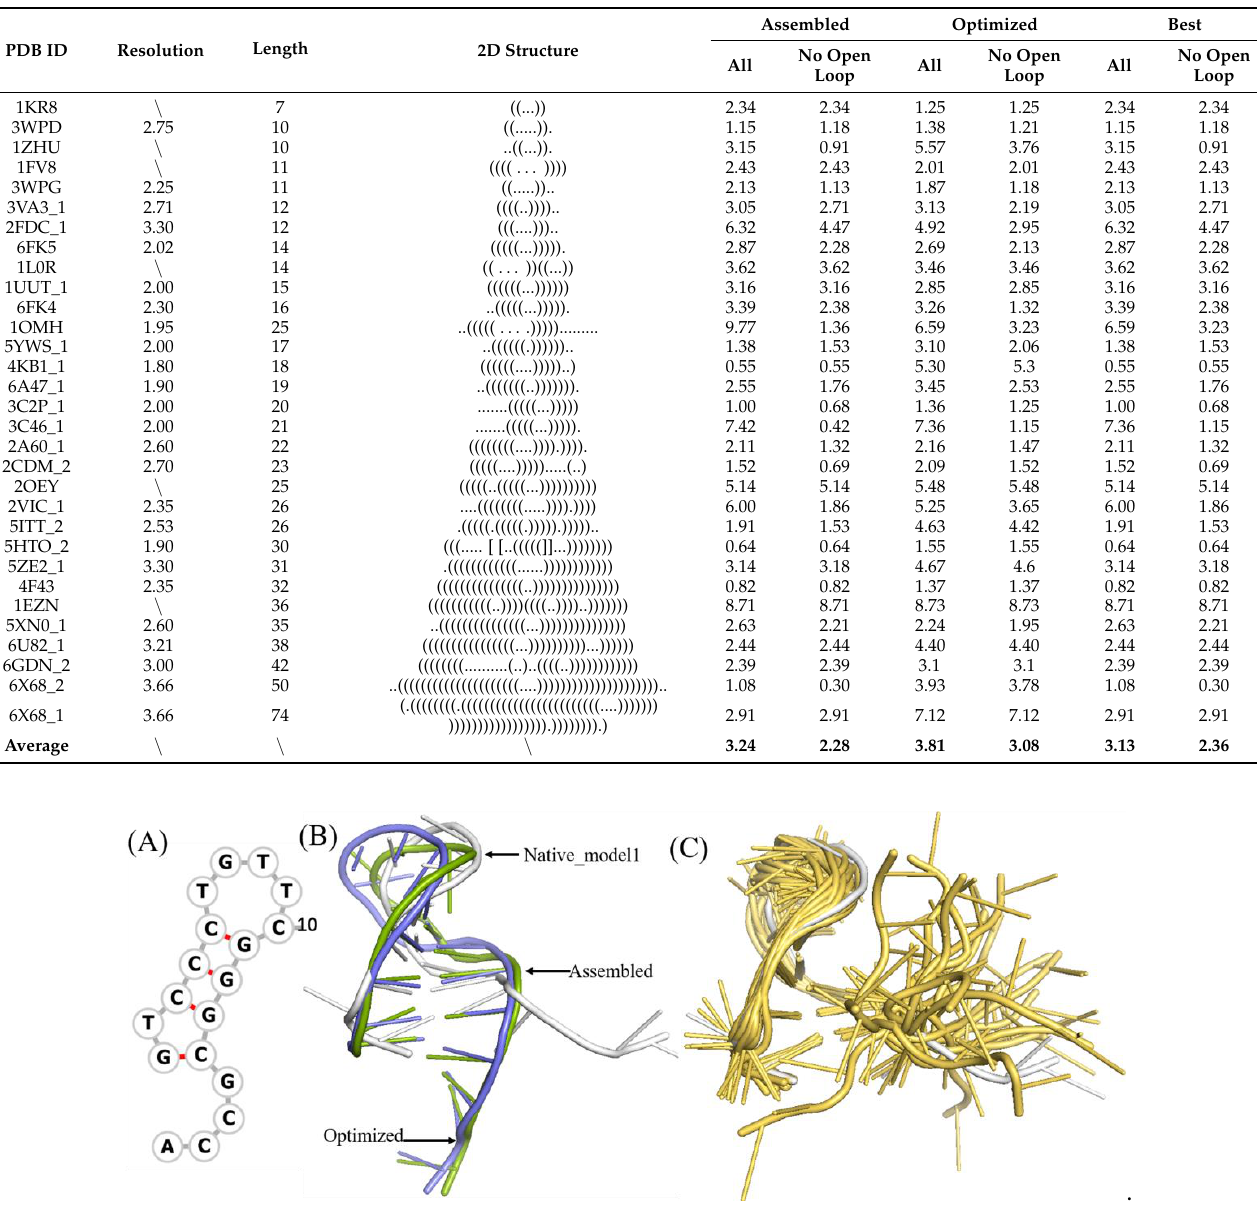
Table 1. Information and prediction accuracies (RMSD in Å) of 31 single-chain DNAs.